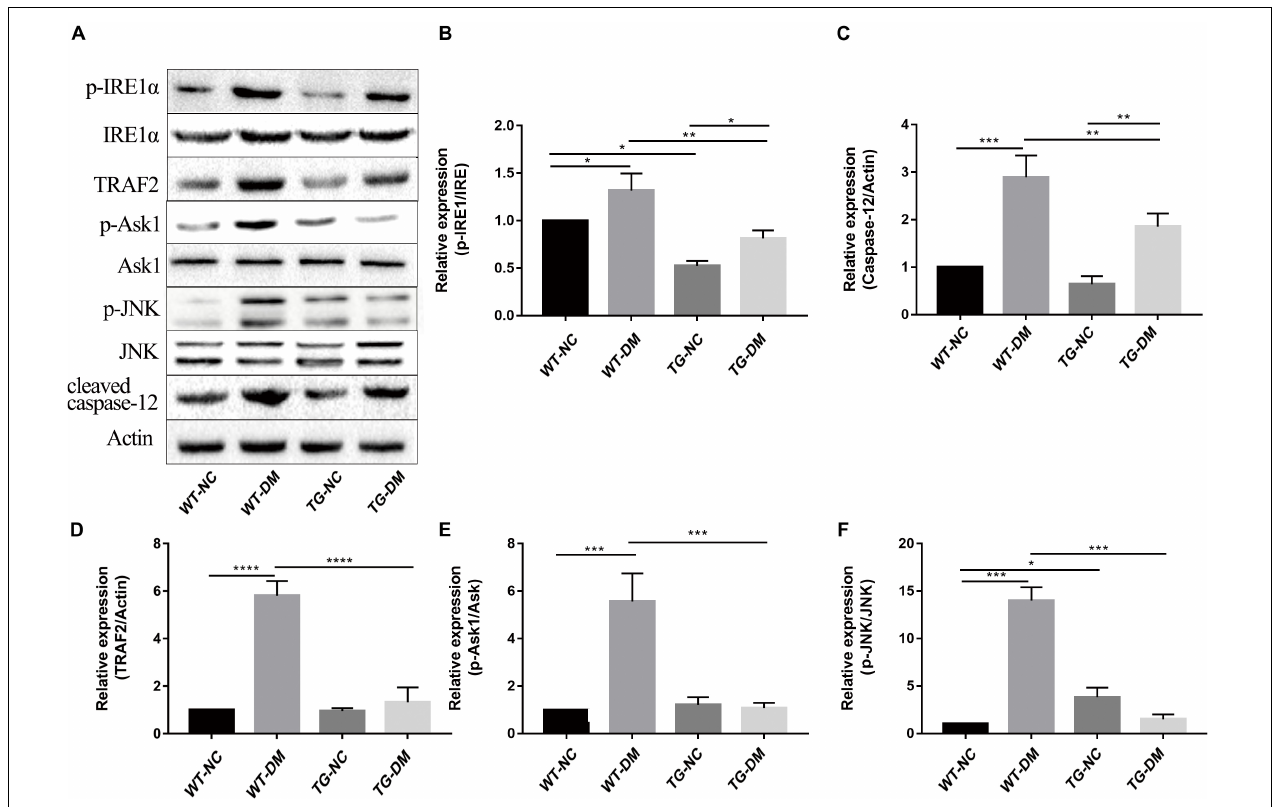
FIGURE 5 | Changes in the activation of IRE1 α , TRAF2, ASK1, JNK, and caspase-12 in the IRE1 α receptor-related pathway signaling pathway in DM mice. (A) Representative protein expression bands of IRE1 α , TRAF2, ASK1, JNK, and caspase-12. (B) Representative Western blot analysis of p-IRE1 α /IRE1 α . (C) Representative Western blot analysis of caspase-12. (D) Representative Western blot analysis of TRAF2. (E) Representative Western blot analysis of p-ASK1/ASK1. (F) Representative Western blot analysis of p-JNK/JNK. Tukey’s post hoc test for one-way ANOVA was used to analyze the Western blot immunocontent. For each group, n = 6. The vertical lines represent the standard error of the mean. * p < 0.05, ** p < 0.01, *** p < 0.001, and **** p <